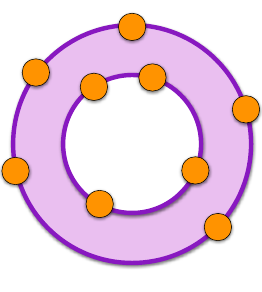
Figure 6 . Annulus diagram. The orange circles on the boundary represent the insertion of meson